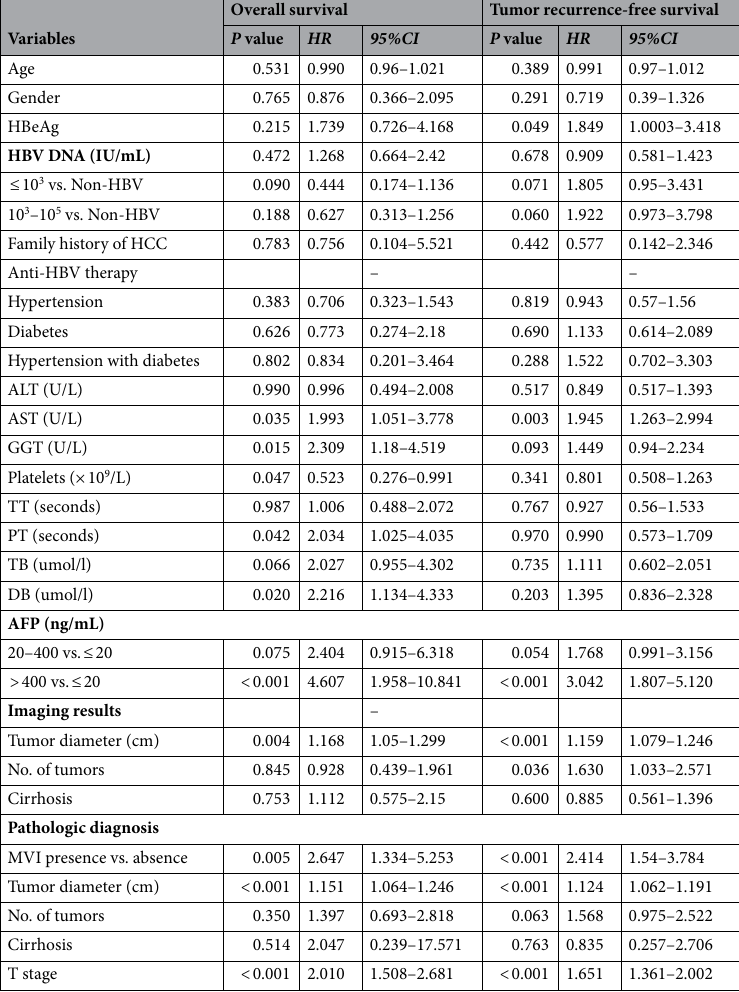
Table 1. Univariate Cox regression analysis for overall survival and tumor recurrence-free survival of HCC patients. HbeAg hepatitis B e antigen, HBV hepatitis B virus, ALT alanine aminotransferase, AST aspartate